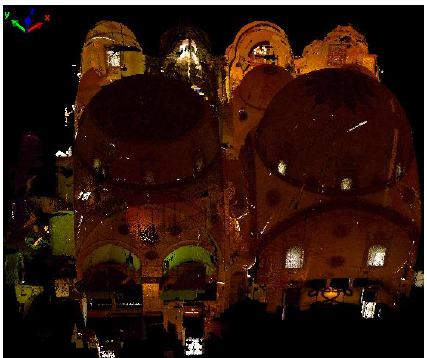
Figure 7. The inside 3-D point cloud model with color.